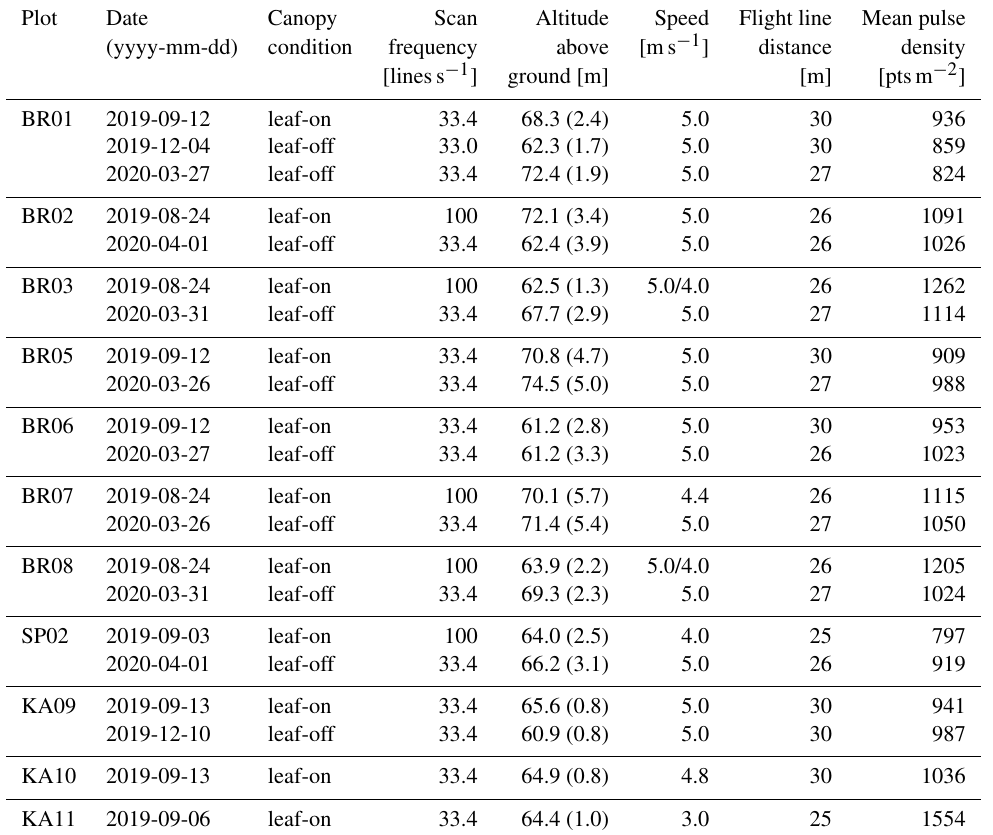
Table 2. UAV-borne laser scanning acquisition parameters per flight and resulting approximate pulse densities, quantified on extracted point clouds of 1ha, thereby excluding points on the flight line edges. For altitude above ground, a mean value is given, with the standard deviation in